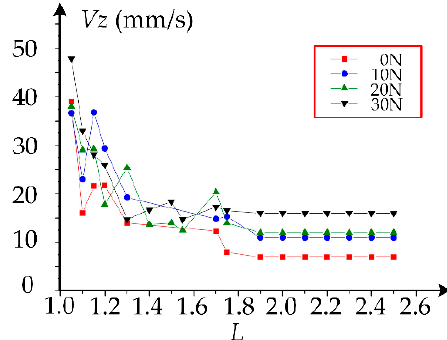
Figure 18. The vibration amplitude with different radial loads.